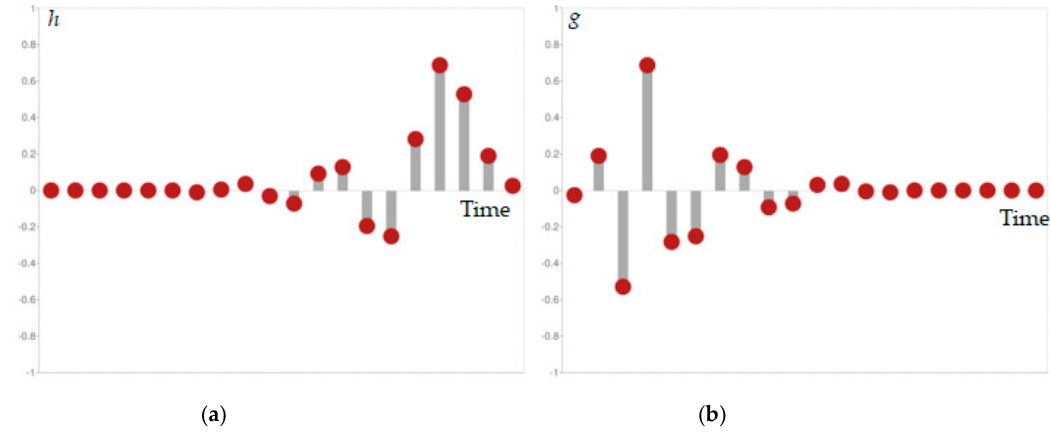
Figure 16. Impulse responses of the low-pass and high-pass filters corresponding to Db10 ( a )impulse response of the low pass-filter; ( b )impulse response of the high pass-filter.